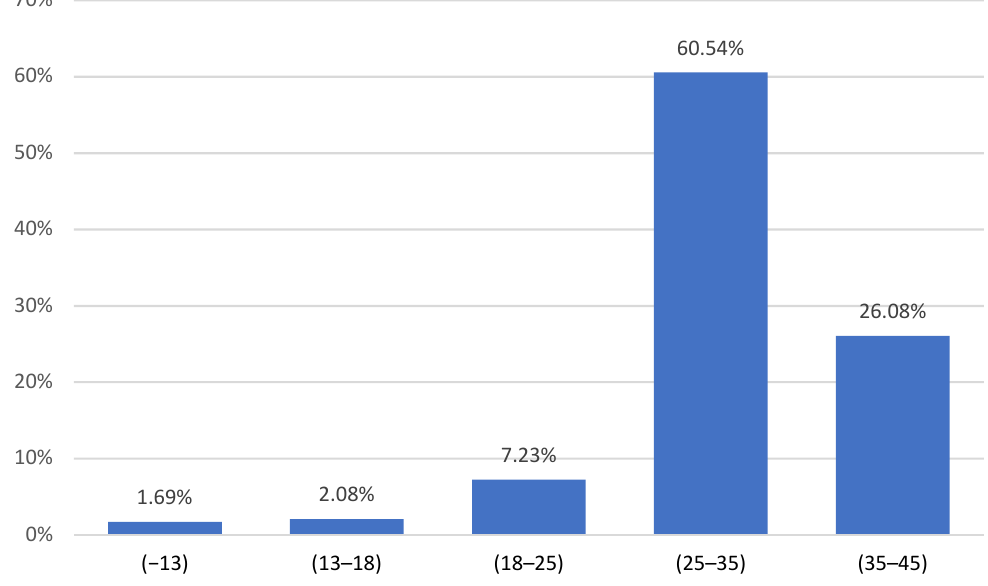
Figure 4. Percentage statistics of the means (Age). Source: own elaboration.